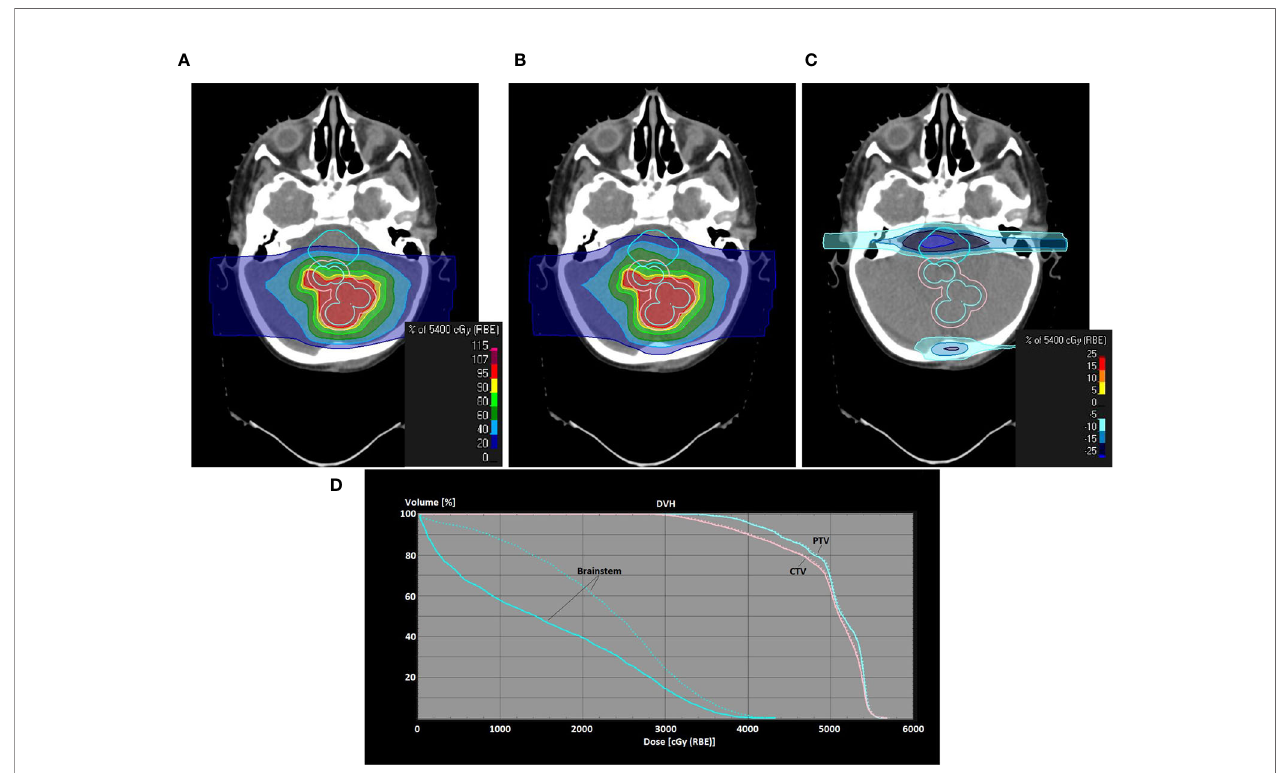
FIGURE 7 | Use of PBS-with-apertures for one of the retreatment cases (metastasis of an atypical teratoid rhabdoid tumor in the fossa posterior). Screenshots of treatment planning in RayStation are shown. Dose distributions in a transversal plane are shown as colorwash (A – C) PBS-with-apertures, uncollimated PBS plan, dose difference between PBS-with-apertures and uncollimated PBS plans; (D) dose volume histogram showing the difference for the brainstem and the target volumes between uncollimated (dashed line) and collimated (solid line) plans. PTV/CTV/brainstem is contoured with an orange/light blue/cyan